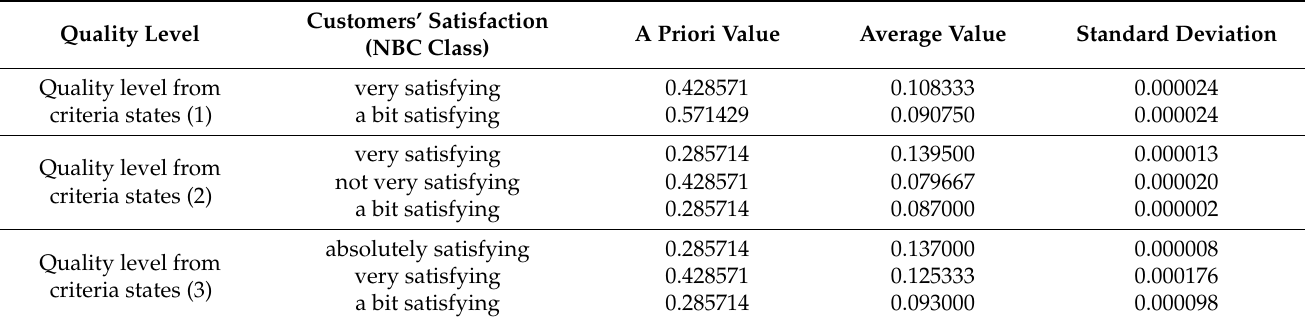
Table 3. Predicted direction of PV improvement after using the Naive Bayesian Classifier. Own